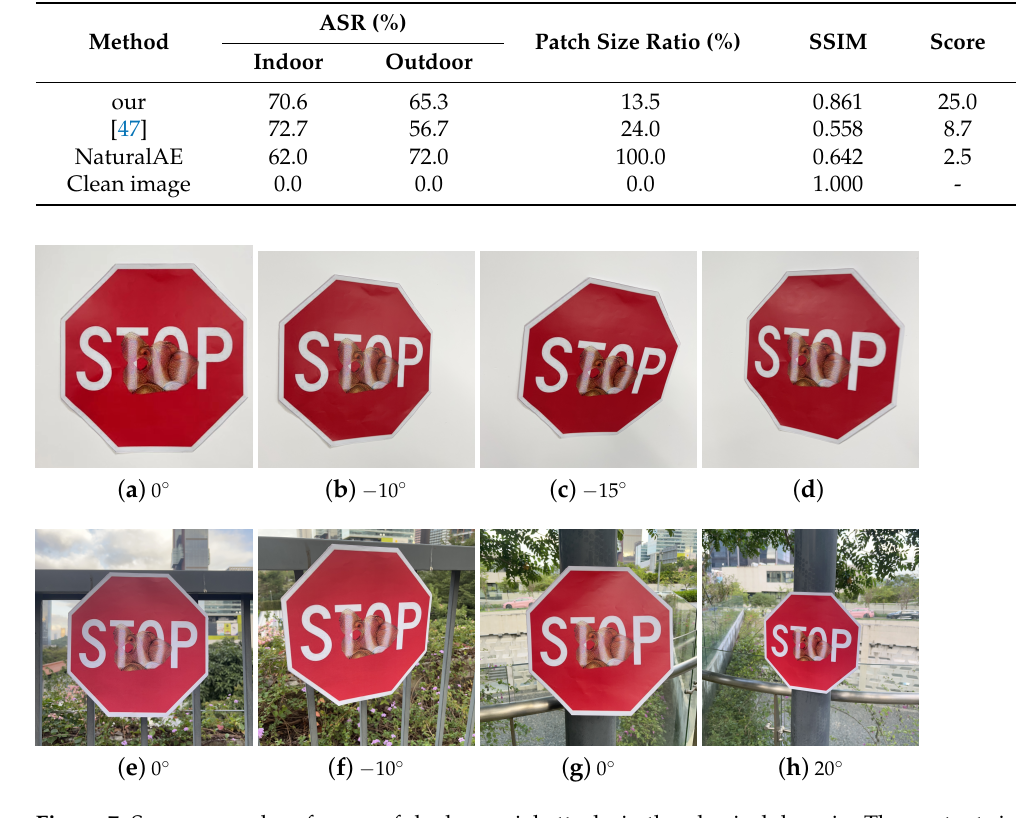
Figure 7. Some examples of successful adversarial attacks in the physical domain. The contents in parentheses indicate the shooting angle. ( a – d ) are adversarial examples under indoor physical scenes, ( e – h ) are adversarial examples under outdoor physical